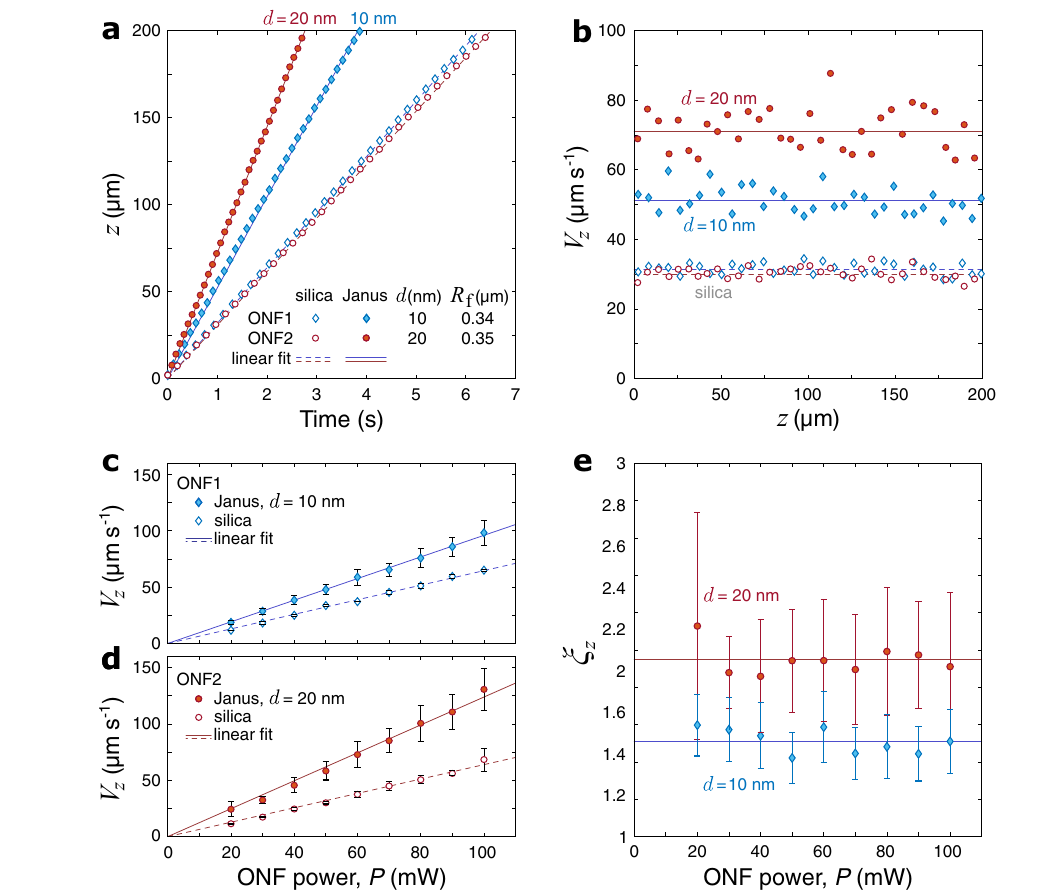
Fig.4|MeasuredoptomechanicsofsilicaandJanusparticlesnearanONF. Input beam1was V -polarized,andweuseddedicatedsampleslabeledasONF1andONF2 for the gold coating thickness of 10nm and 20nm, respectively (see Supplemen- tary Movie 2). a Sample position-time series for the longitudinal direction of the particle motion at a transmitted optical power of 50 mW. Markers indicate the z coordinateoftheparticle ’ scenter(withrespecttothatinthe fi rstframe);linesrefer to the best linear fi t to the data. b Propulsion speed as a function of the particle ’ s position along the ONF waist. Lines indicate the mean speed values which are (in